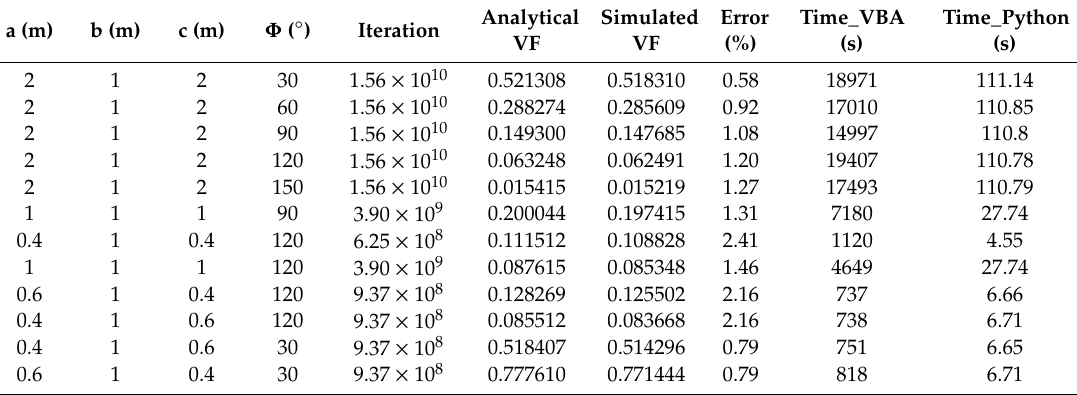
Table A3. View factor for element size h i = 0.004